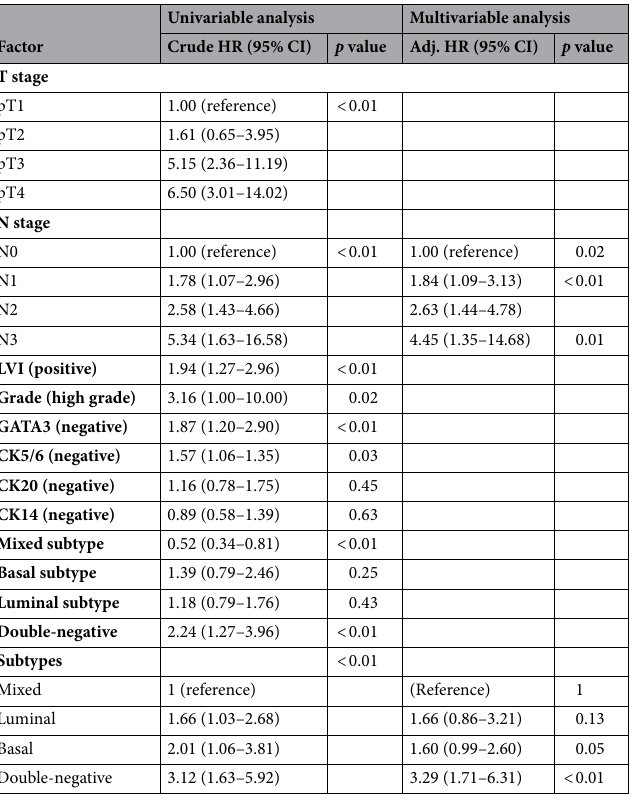
Table 4. Univariable and multivariable regression analyses of clinical outcomes in 132 patients with MIBC. Crude HR: crude hazard ratio; adj. HR: adjusted hazard ratio; 95% CI: 95% confidence interval; LVI: